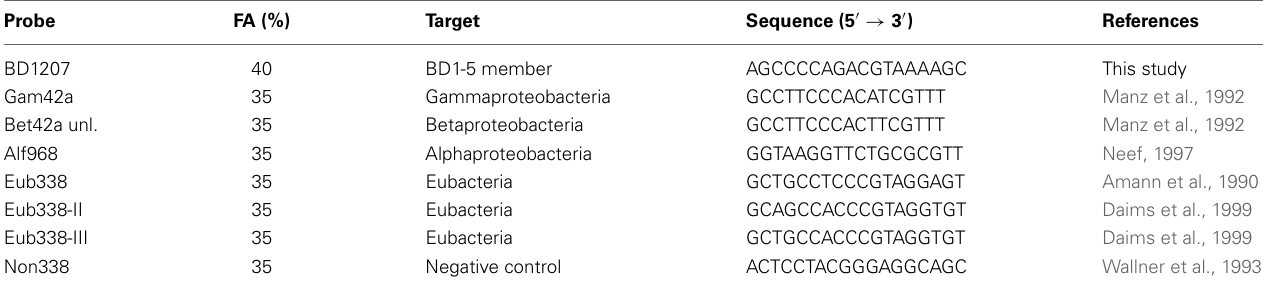
Table 2 | Oligonucleotide probes used for FISH analyses in this study.